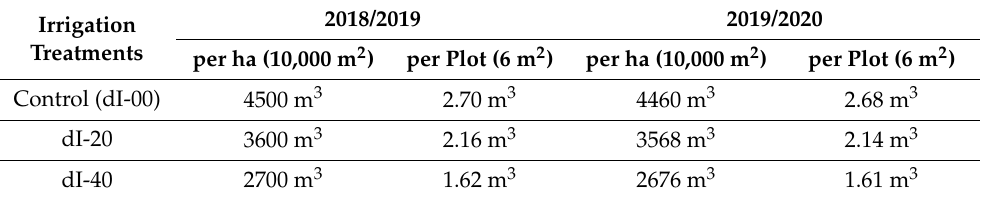
Table 2. IWA for each imposed stress in both experimental seasons. Irrigation